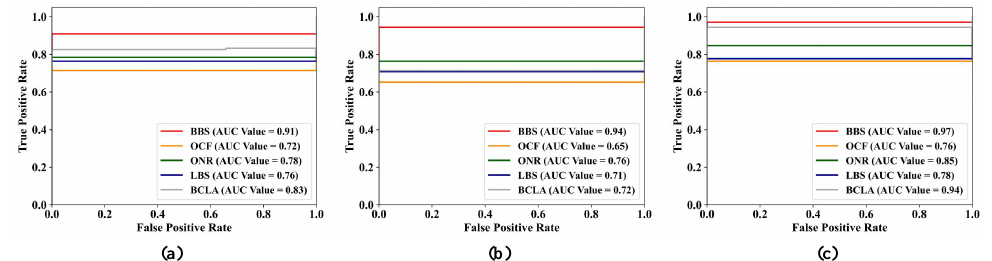
Figure 16. The ROC of ( P D , P F ) for the UTD results on the turbid water data set with different band selection methods. The number of selected bands is ( a ) 8, ( b ) 18, ( c ) 27.